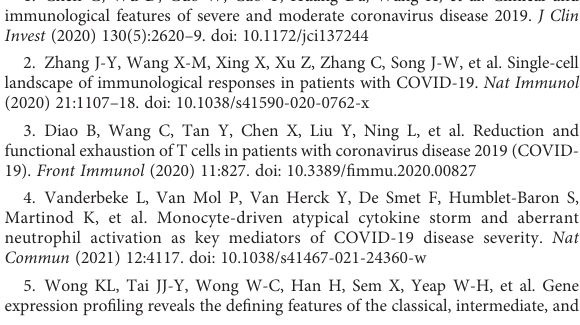
SUPPLEMENTARY FILE 2 Table showing differential gene expression between the new Naïve T cell subset vs Naïve CD4+/CD8+ T cell in the healthy vs recovered individuals. SUPPLEMENTARY FILE 3 Pseudobulk differential gene expression of the cell types highlighted in the study. SUPPLEMENTARY FILE 4 GO enrichment analysis of the genes from each